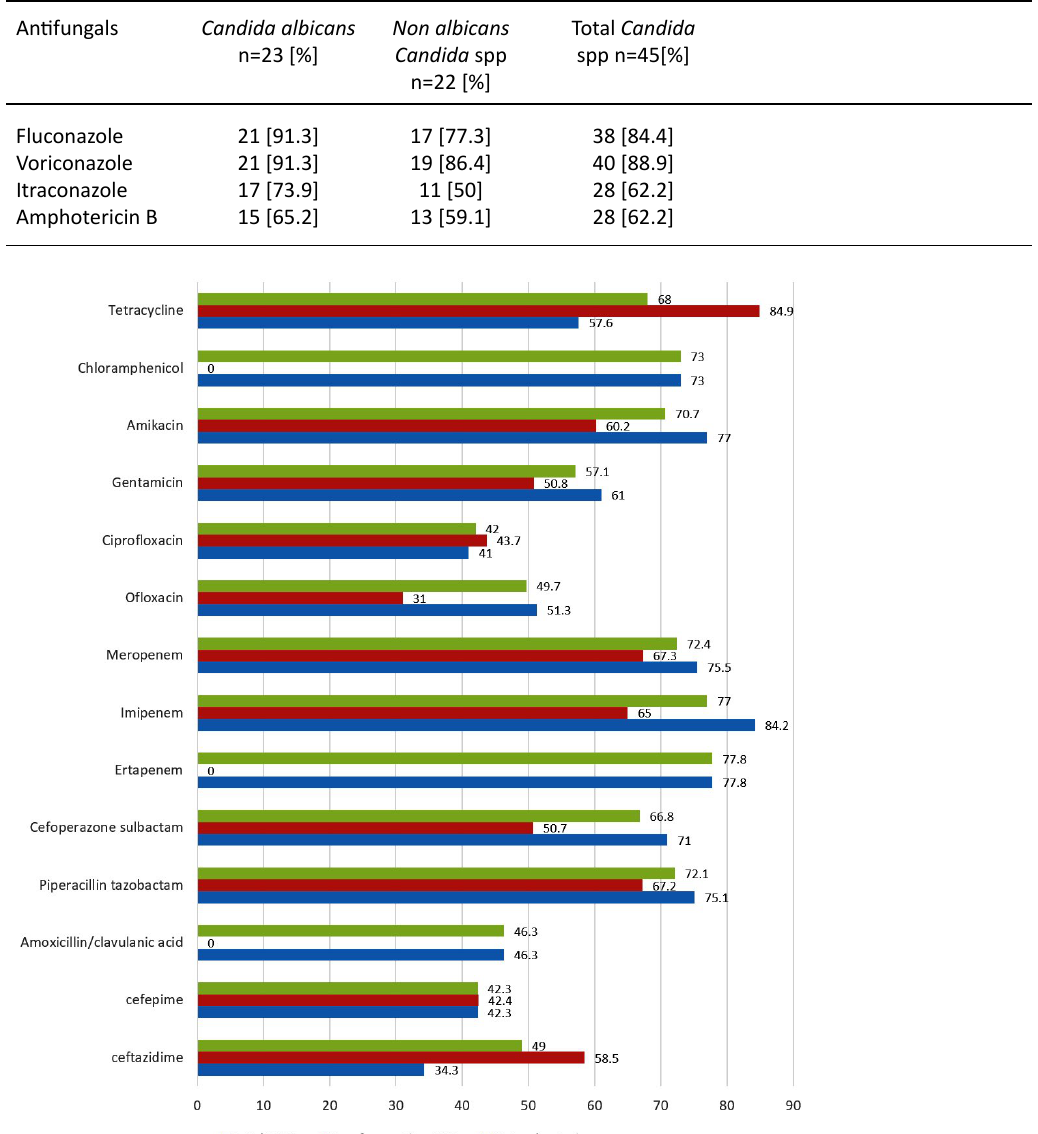
Table 4. Percentage of susceptible strains among Candida species analyzed in the study